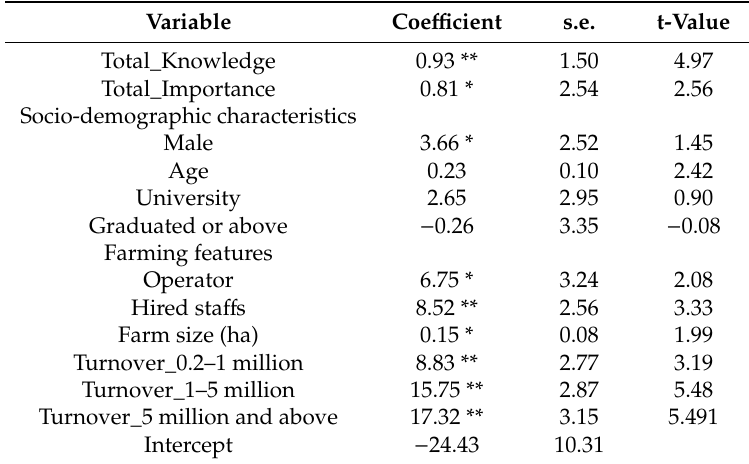
Table 5. Estimation results of the ordinary least squares (OLS) regression (Dependent variable: SA adoption, n =